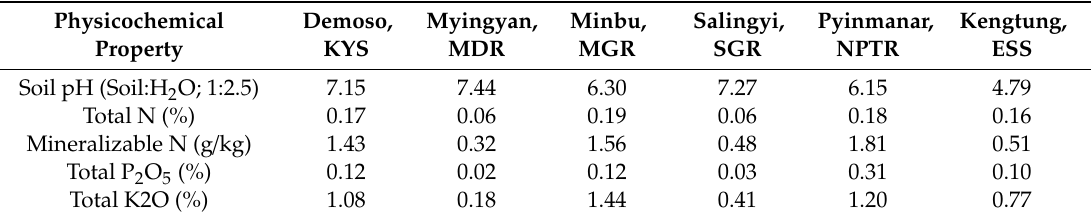
Table 2. Physicochemical properties of